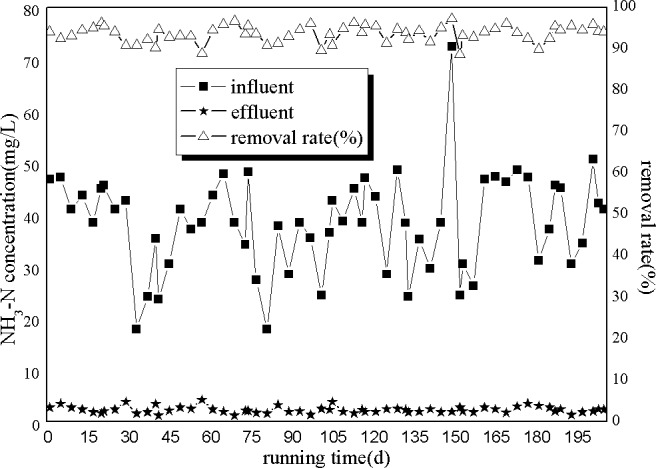
Removal of NH3-N by A/O processes.